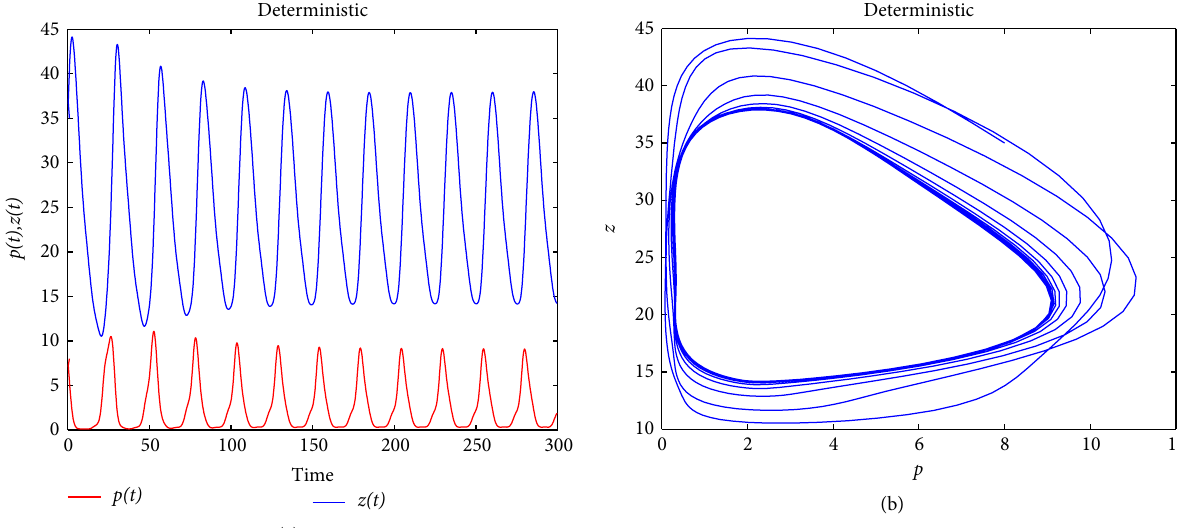
Figure 4: The solutions and phase diagram of the deterministic periodic system (74) with taken as Eq. (77).